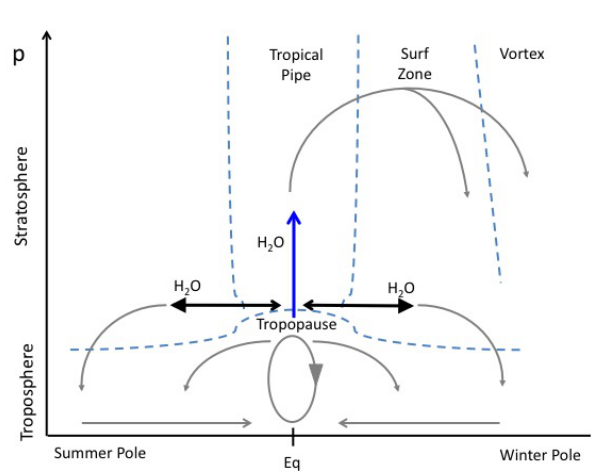
Fig. 1. Schematic of the Brewer-Dobson circulation in the stratosphere. In the lowermost stratosphere equatorial air is transported and mixed towards both poles (thick black arrows) before it reenters the troposphere at higher latitudes and returns towards the Equator (Eq). The rising air masses in the tropics are transported towards the winter pole higher up, cross the tropical pipe and descend into the ”surf zone” and the polar vortex. We focus on the three branches highlighted by the thicker blue and black arrows which distribute H 2 O in the stratosphere. The ellipse and the two poleward directed arrows represent the Hadley circulation in the troposphere.